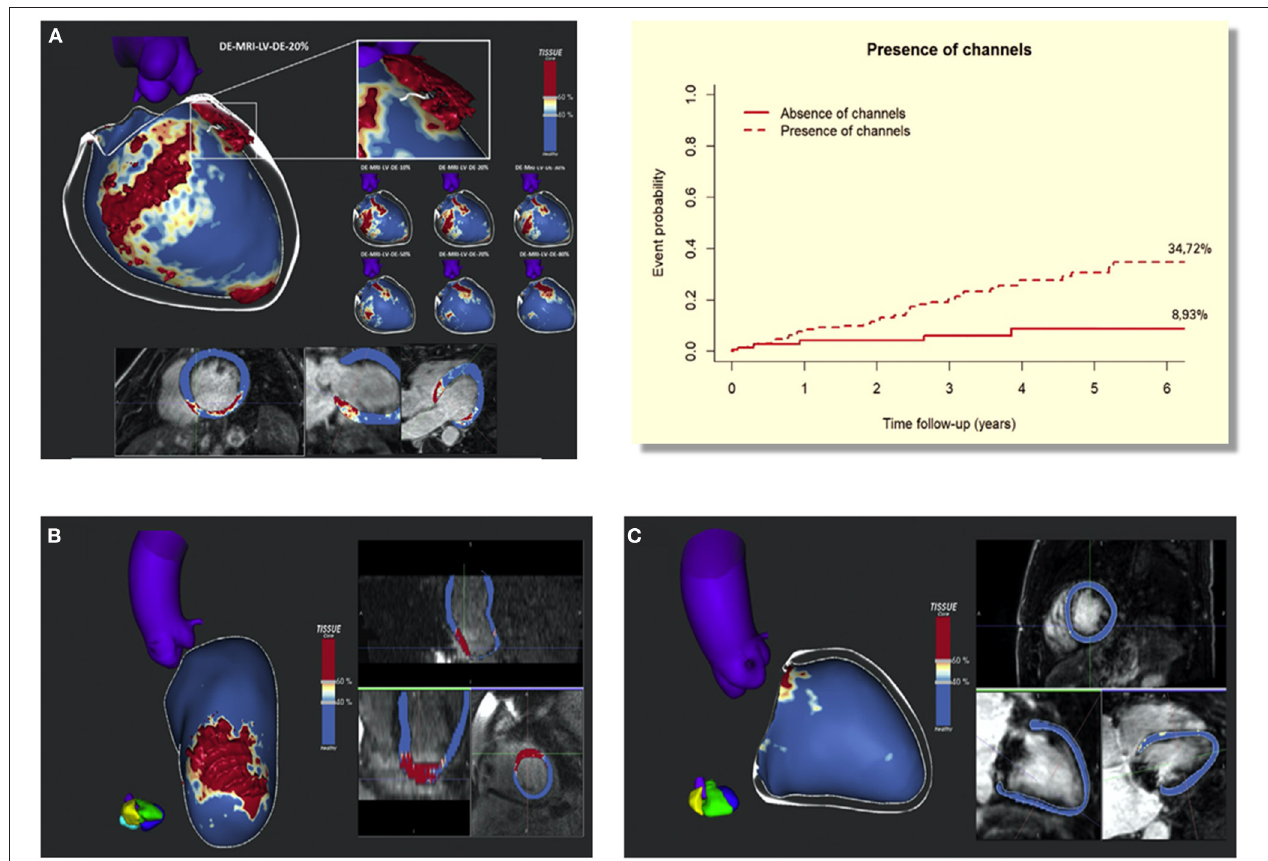
FIGURE 6 | Adapted from Sánchez-Somonte et al. (54). (A) Late gadolinium enhancement-cardiac magnetic resonance (LGE-CMR) reconstruction of the left ventricle (LV) with a posteroseptal scar (core in red, BZ in white, and healthy myocardium in blue). A white line is drawn over the surface, representing a conducting channel. We can see the substrate evolution through different layers, from the endocardium (10–30%) to the epicardium (70–90%), with a defined channel in different layers. (B) LGE-CMR reconstruction of the LV with an anterior scar. In this case the scar is very homogeneous (mainly composed of core tissue) compared with the scar in panel (A) and it has no conducting channels. (C) LGE-CMR reconstruction of the LV without scar. BZ, 5 border zone; LGE-CMR, 5 late gadolinium enhanced cardiac magnetic resonance; LV, 5 left ventricle. Upper right panel shows cumulative incidence functions for appropriate therapies depending on scar mass > 10g and the present channels. At 6-year follow-up, 37.65% of patients with channels and scar mass > 10g reached the primary end point compared with 2.78% of patients without channels and scar mass <